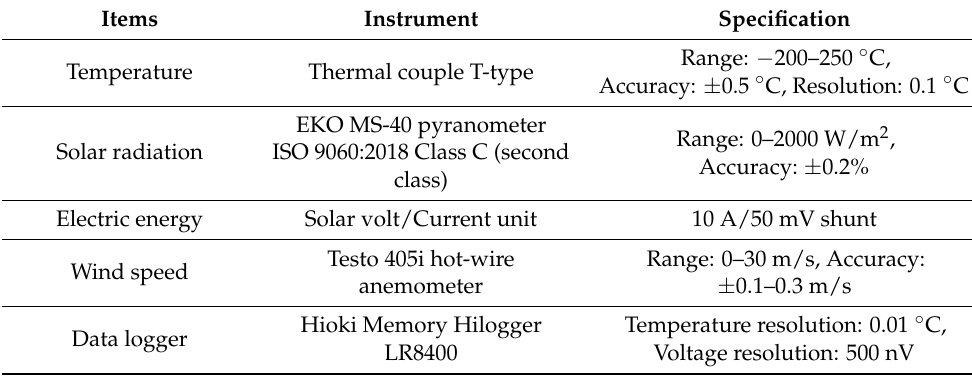
Table 1. Equipment specification.